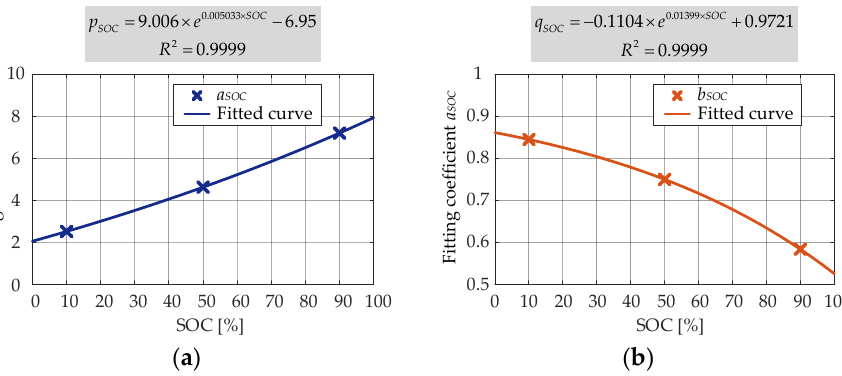
Figure 18. The relationship between the curve fitting coefficients and the corresponding storage temperature. ( a ) Exponential relationship between a SOC and SOC , ( b ) Exponential relationship between b SOC and SOC .